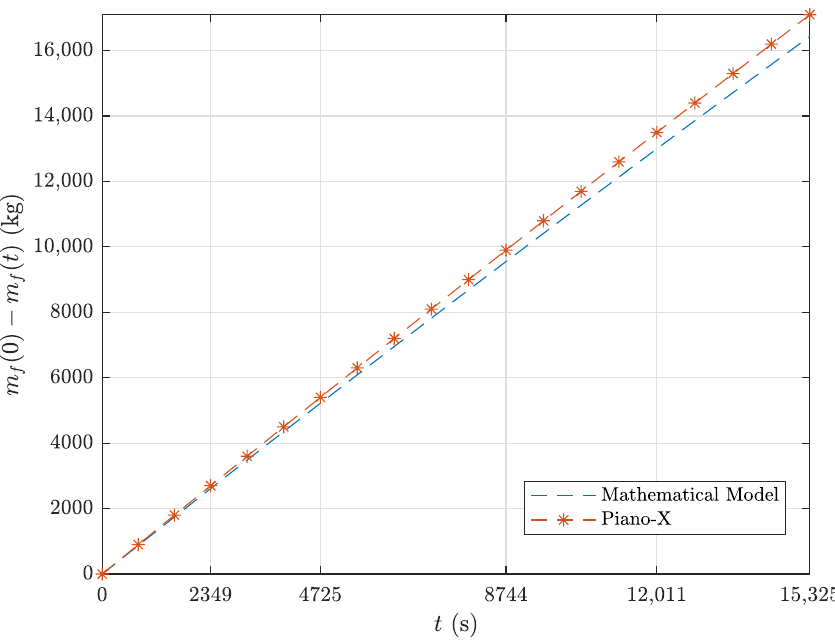
Figure 2. The time evolution of the fuel mass consumed ( m f ( 0 ) − m f ( t ) ) is presented for both the mathematical model and the Piano-X